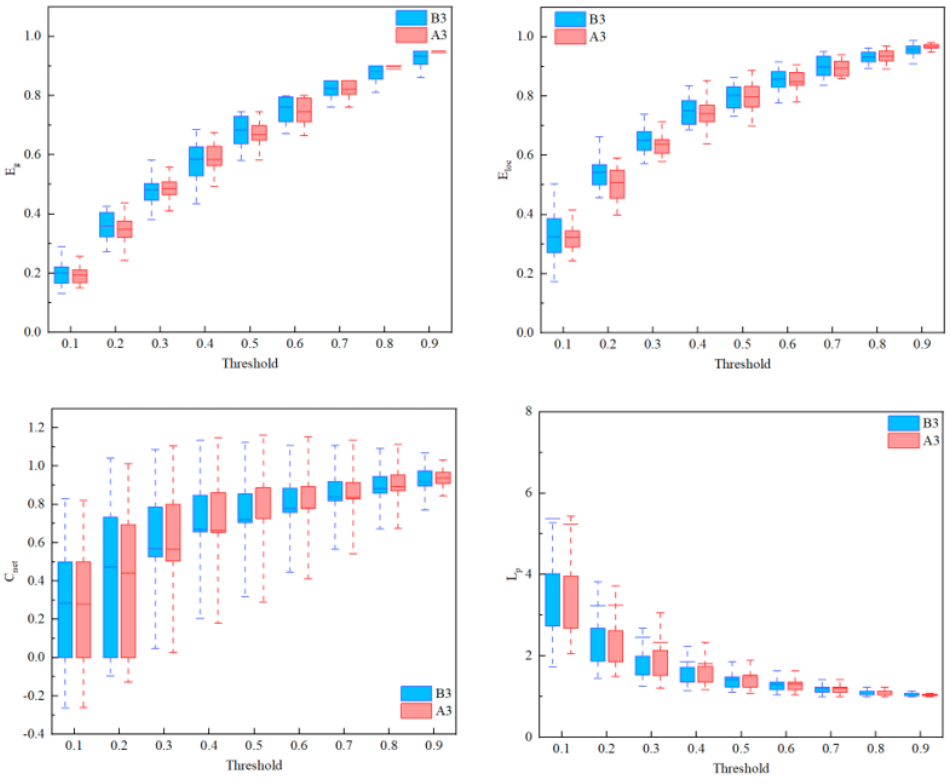
Figure 5. Comparison of the brain network among 3 shifts coal mine workers between before and after shift work: network efficiency. The horizontal axes show the threshold values (T ∈ (0.1:0.1:0.9)), and the vertical axes show the network properties indexes ( p < 0.05). ( a ) Group 1. ( b ) Group 2. ( c ) Group 3. The small-world analysis results for three groups are displayed in Figure 6. Similar to the results of previous studies, the small-world parameters ( 𝛾,𝜆,𝜎 ) decreased with increasing thresholds for all three groups of coal mine workers before and after their work shifts [51,59,60]. In addition, all the 𝜎 ≫ 1 represented a small-world property of the resting-state brain networks of all three groups of coal mine workers before and after their shifts.